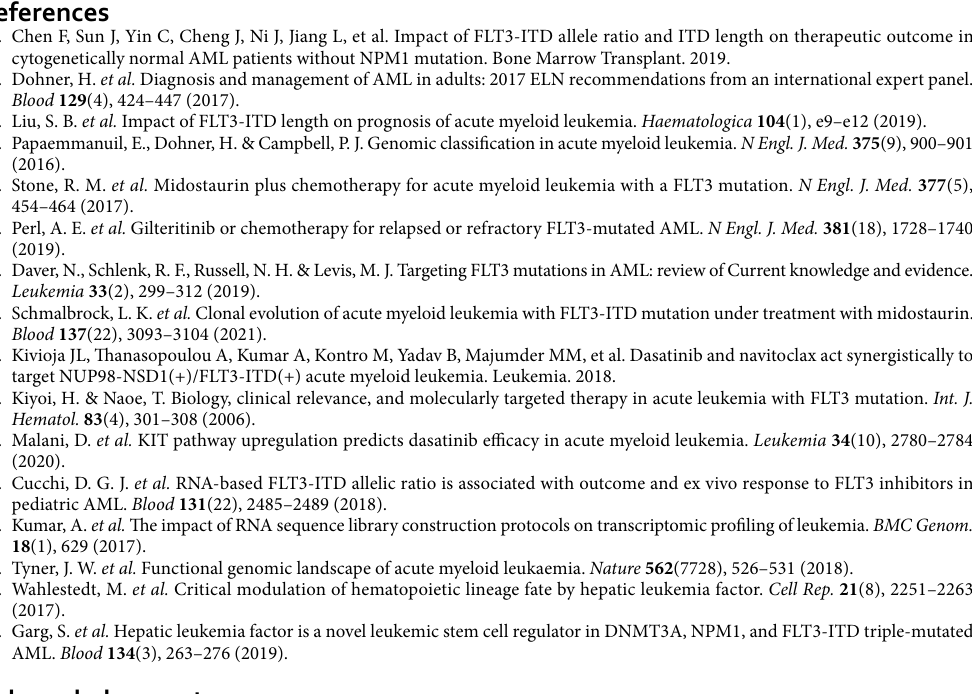
Figure 2. Gene expression profiles associated with FLT3 -ITD-AR and FLT3 inhibitor response. ( A ) The volcano plot depicts protein coding genes (N = 14 141) with positive (red) or negative (blue) association with the ITD-AR identified by linear regression analysis of FLT3 -ITD + samples (N = 31). The genes with FDR < 0.1 and log2 fold change > 5 were considered significant. ( B ) qPCR validation experiment with 20 FLT3 -ITD + RNA samples confirmed association of HLF with ITD-AR. The figure shows correlation analysis of relative HLF quantity and ITD-AR levels. The HLF expression was normalized against four reference genes ( EIF4B , RPL19 , SH3D19 , and NACA ) with uniform expression across samples. ( C ) Expression of HLF was compared between FLT3 -ITD + and FLT3 -WT patients using the BeatAML dataset. ( D ) The waterfall plot shows Pearson correlation coefficients between HLF gene expression (Log2 CPM) and selective FLT3 inhibitor responses in FLT3- WT and FLT3 -ITD + samples. Response to six inhibitors were associated ( P < 0.05) with HLF expression. Significant associations are denoted with an asterisk (*, P < 0.05). ( E , F ) FLT3 inhibitor sorafenib was selected for the treatment of three chemorefractory AML patients based on ex vivo DSRT and molecular profiling. ITD-AR and HLF expression were retrospectively correlated with clinical response to sorafenib. The treatment outcomes were defined as complete remission with incomplete hematological recovery (CRi), partial remission (PR) and resistant disease (RD) evaluated based on ELN 2017